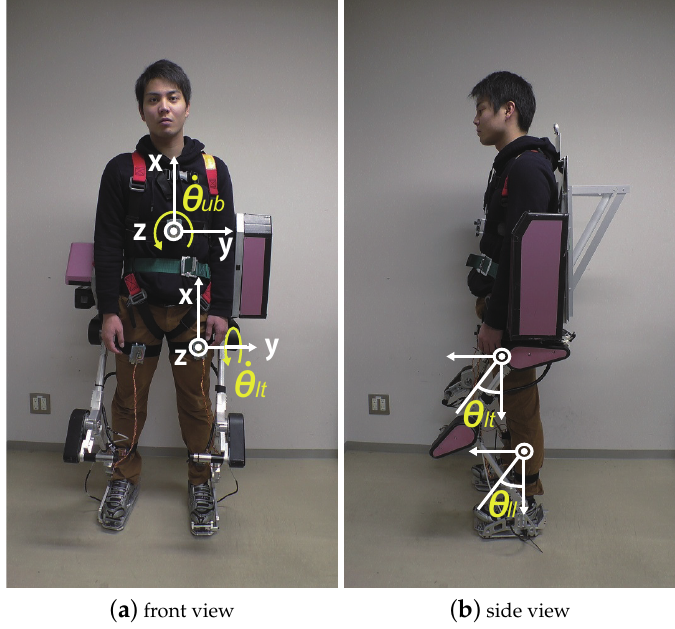
Figure 2. Motion sensors attached to the body of the wearer, and the definition of the axes.